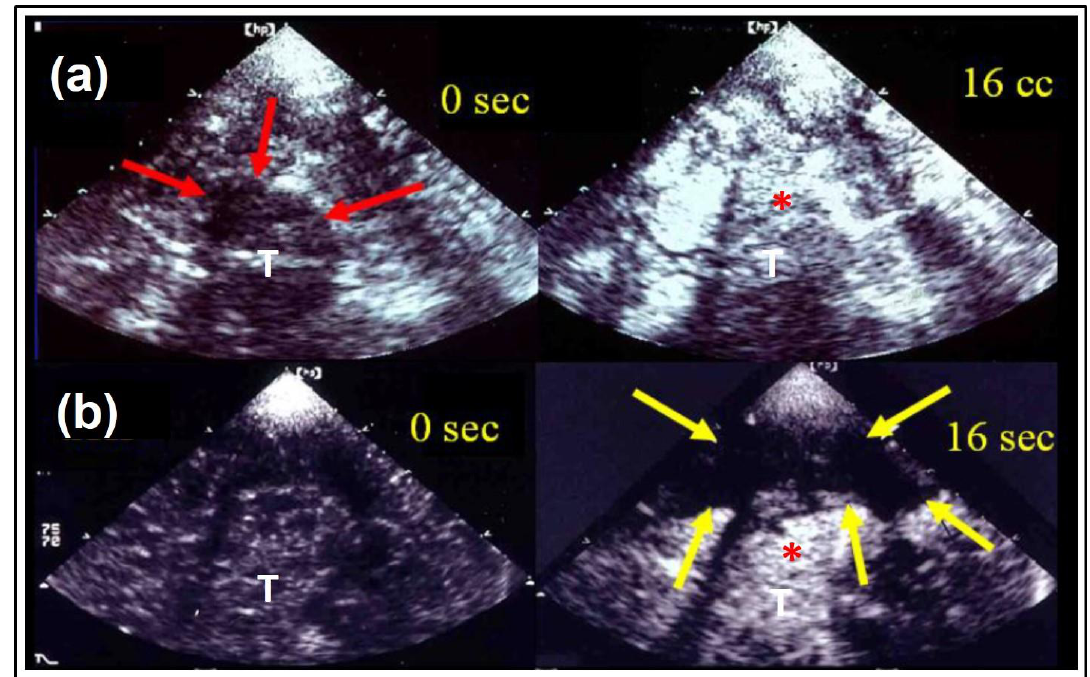
Figure 2. Ultrasound perfusion imaging in the course of time. Early “unilateral” gray-scale imaging in a healthy volunteer ( a ) and an acute stroke patient ( b ) corresponding to Figure 1: at baseline (0 s) and after contrast enhancer application at the time of maximal contrast enhancement (16 s). The thalamic region (red arrows) is marked with increase of brightness in both examples (*), whereas the regions of the lentiform nucleus and temporoparietal lobe are spared (yellow arrows), where later infarction was demonstrated in CCT follow-up. (T) indicates the third ventricle, adapted from [15] with permission from Elsevier.